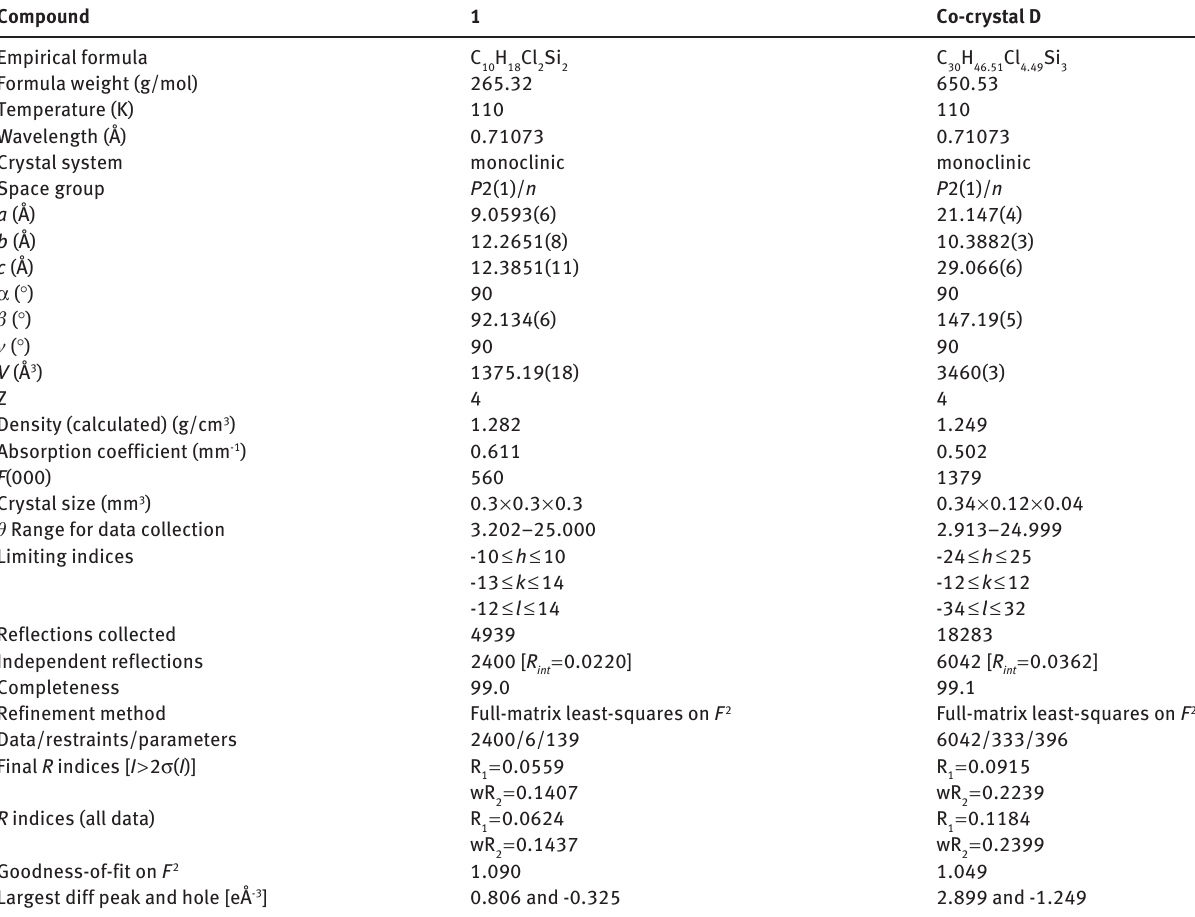
Table 1: Crystallographic data and structure refinement details for compound 1 and co-crystal D composed of 3a-3c, B, 2 . Compound